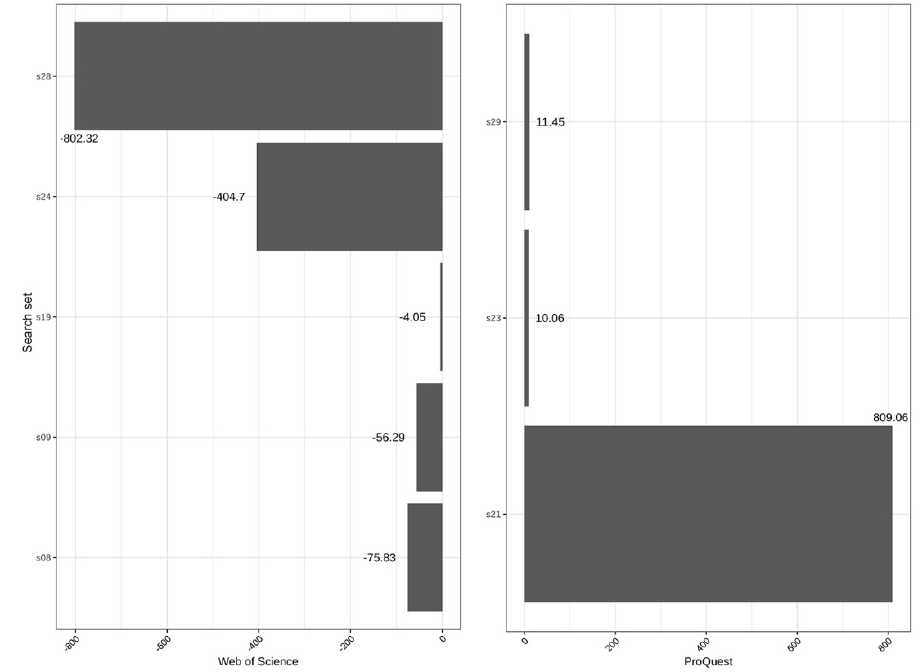
Figure 3 Outlier search results in ProQuest and Web of